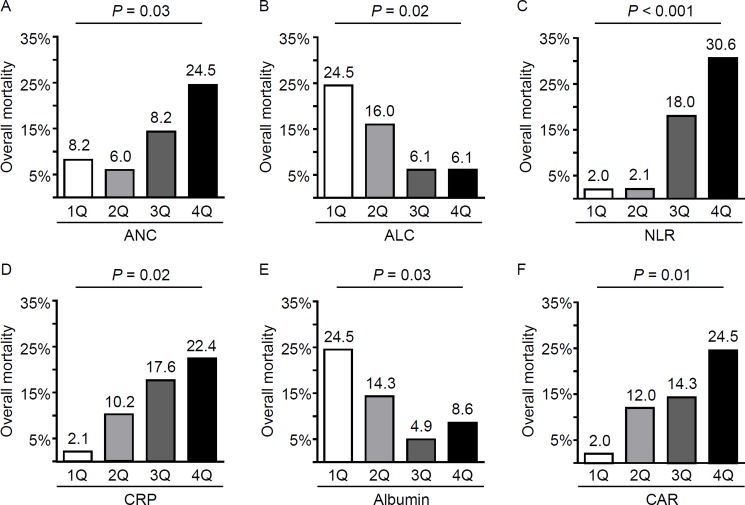
The distribution of non-survivors based on the quartiles of absolute neutrophil and lymphocyte counts, and serum CRP and albumin levels in patients with polymyositis/dermatomyositis.The prevalence of non-survivors increased across quartiles for absolute neutrophil count (ANC, A), and decreased across quartiles for absolute lymphocyte count (ALC, B). Consequently, the prevalence of non-survivors was the largest in the highest quartile of the neutrophil/lymphocyte ratio (NLR, C). Also, the prevalence of non-survivor increased with increasing quartiles of C-reactive protein (CRP, D), and with lower quartiles for albumin (E). Consequently, the distribution of non-survivors was significantly different among CRP/albumin ratio (CAR) quartiles (F). P values were calculated by chi-square test.